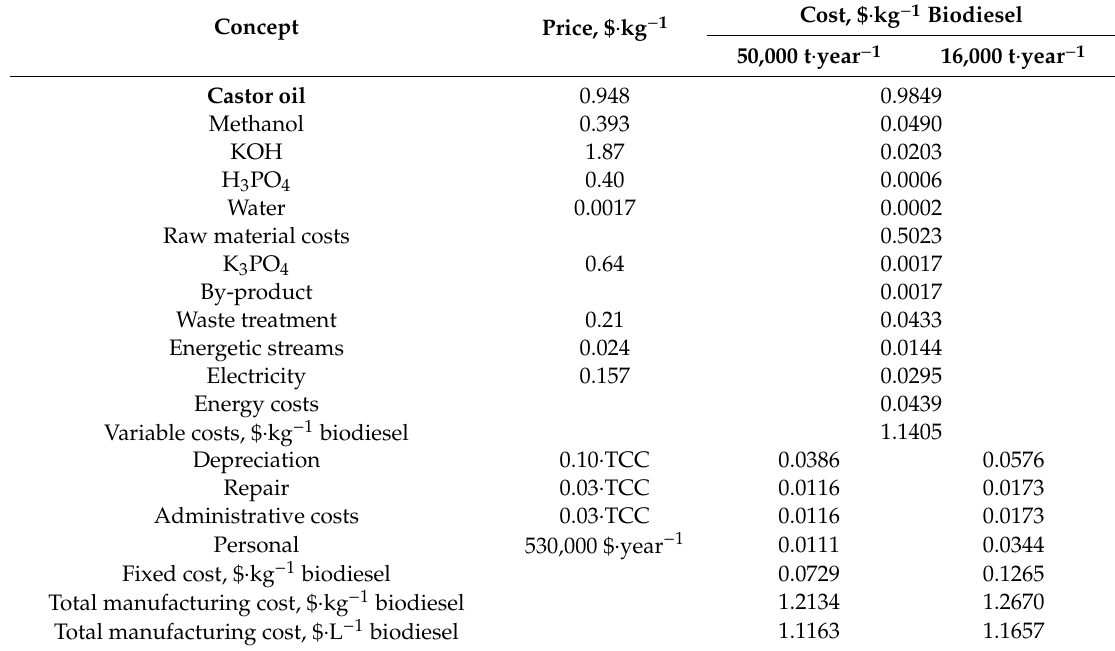
Table 9. Annual manufacturing